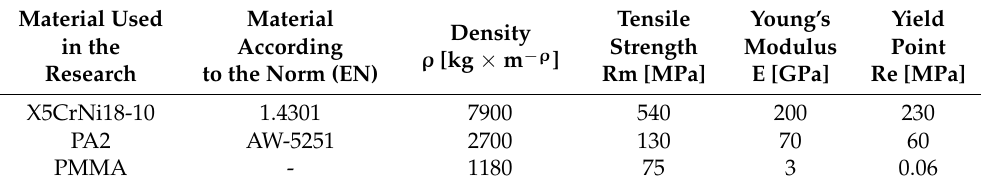
Table 1. Mechanical and physical properties of materials used in the research.